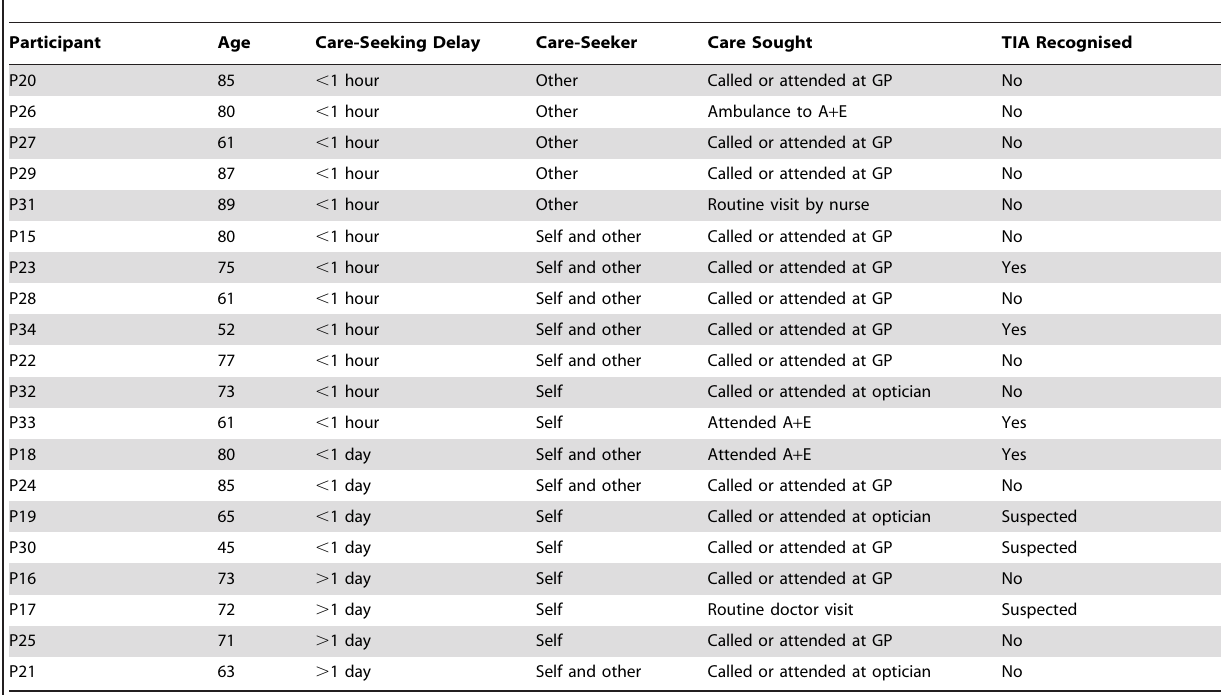
Table 1. Age, care-seeking delay, care-seeker, care sought and TIA recognition for all participants.